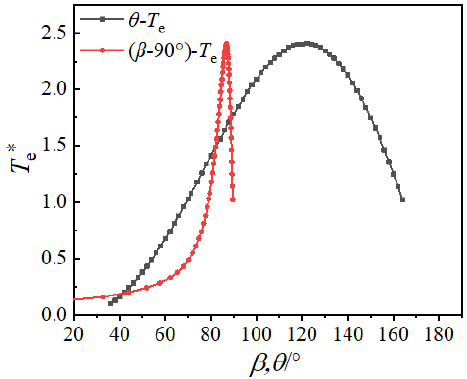
Figure 5. The θ-T e and ( β −90°) -T e curves with per unit value. At the same time, the θ and β relationship curve and the power factor curve can be drawn as the torque increases. As shown in Figure 6, the valley in the power factor curve is apparent.